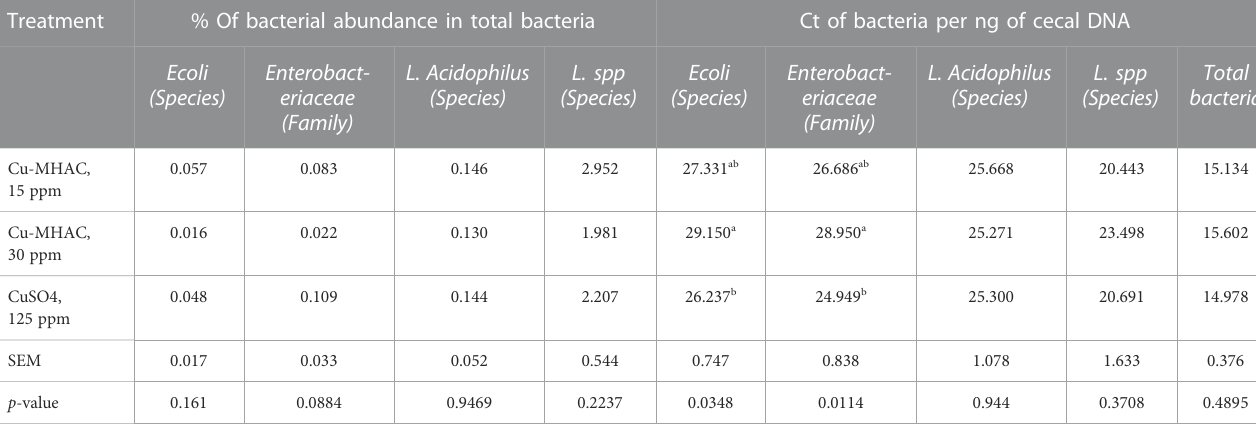
TABLE 11 Ct of Firmicutes , E. Coli , Lactobacillus Acidophilus , Lactobacillus spp . and Enterobacteriaceae per ng of cecal DNA, and percentage (%) of Firmicutes , E. Coli , Lactobacillus Acidophilus , Lactobacillus spp . and Enterobacteriaceae (% of total bacteria) in broilers at 43 days of age of experiment #2. Treatment % Of bacterial abundance in total bacteria